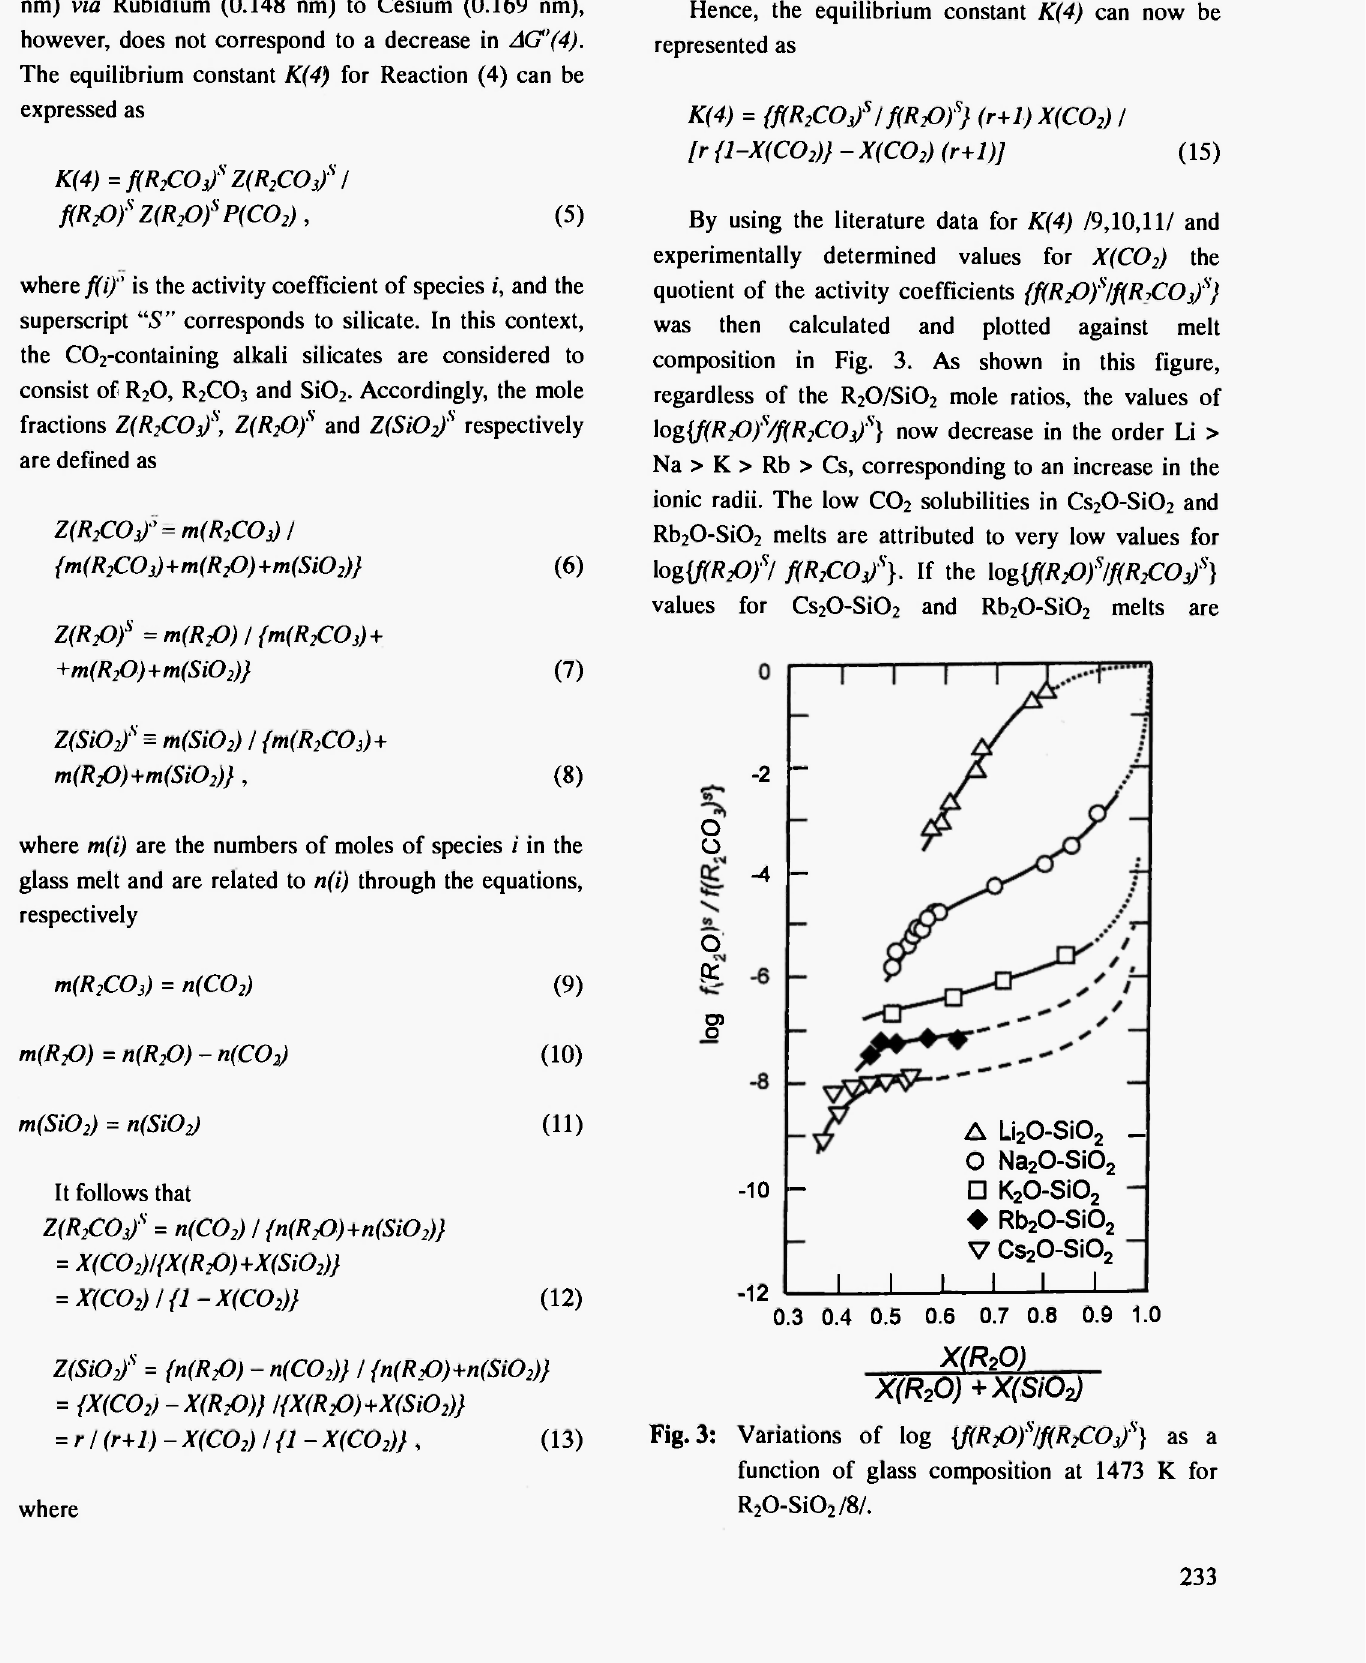
Fig. 3: Variations of log {/(Rfif/flRiCO/} as a function of glass composition at 1473 Κ for R 2 0-Si0 2